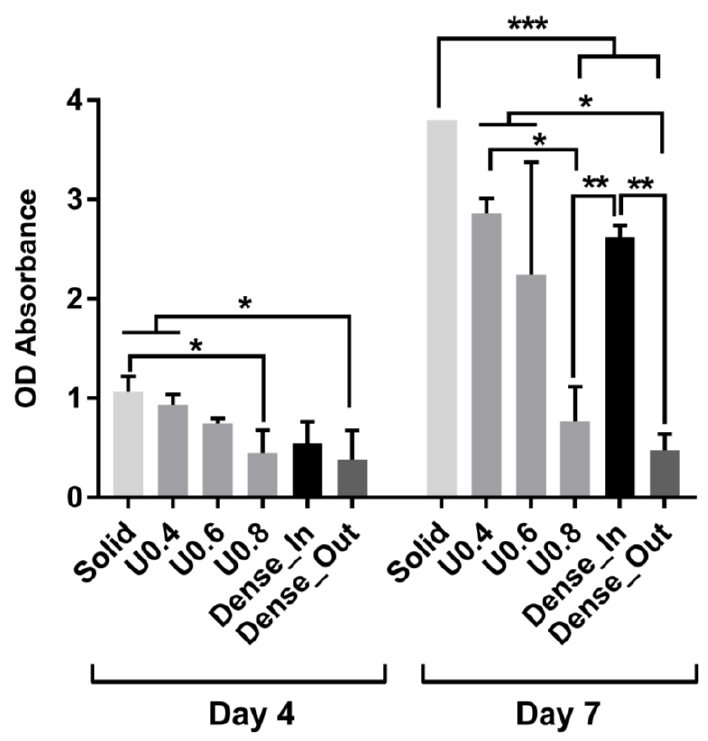
Figure 7. Cell proliferation measured by MTS assay after culturing 4 and 7 days on the uniform and gradient porous structures. The optical absorbance (OD) was measured at 490 nm. Data were presented as mean ± SD ( n = 3). (* p < 0.05, ** p < 0.01, *** p < 0.001 when compared using ANOVA Tukey – Kramer post-hoc test).